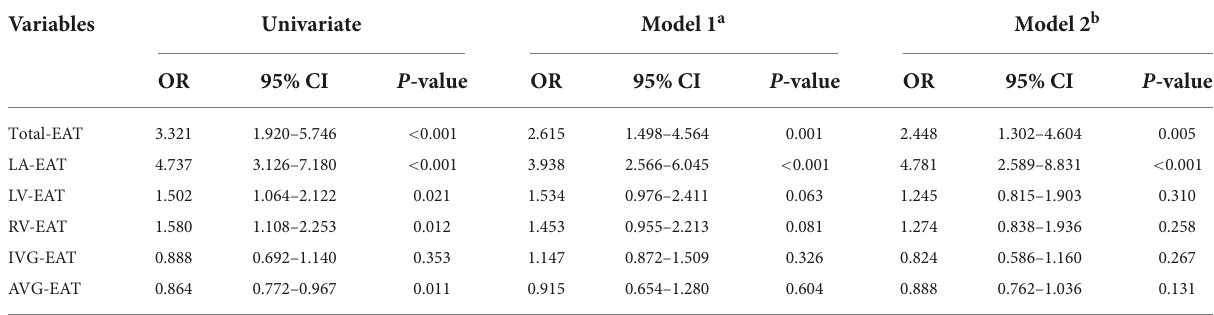
TABLE 3 Logistic regression analysis to evaluate the impact of EAT on the presence of